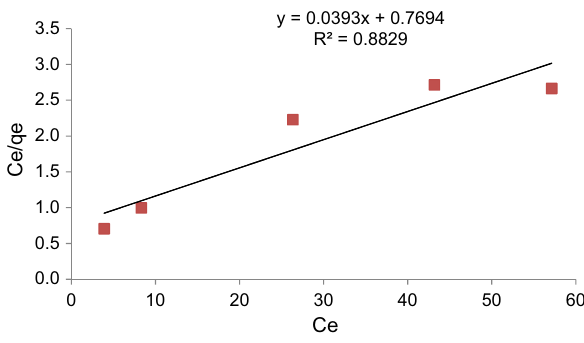
Fig. 5 Langmuir adsorption isotherm plot of Cd(II) ion onto UMSFS biomass